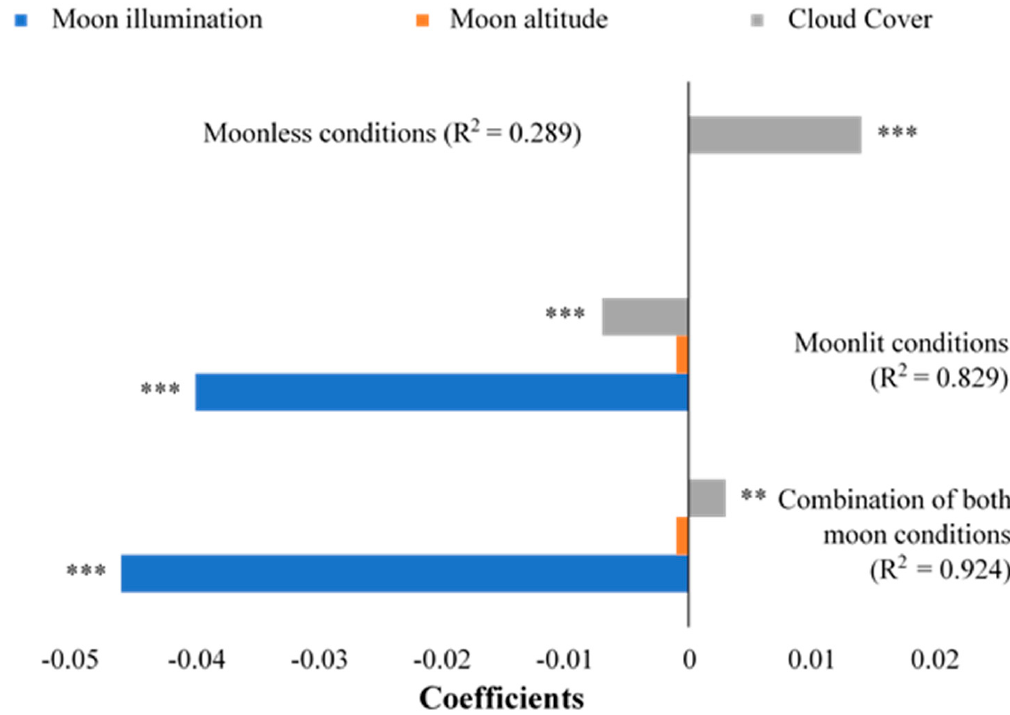
Figure 11. The coe ffi cients for the variables determining brightness in the primary backward stepwise multiple linear regression models for zenith photographs’ landward cone of acceptance (COA) sectors. Significant variables are denoted with an asterisk (* = p < 0.05, ** = p < 0.01, *** = p < 0.001) and the adjusted R 2 for each model shown.